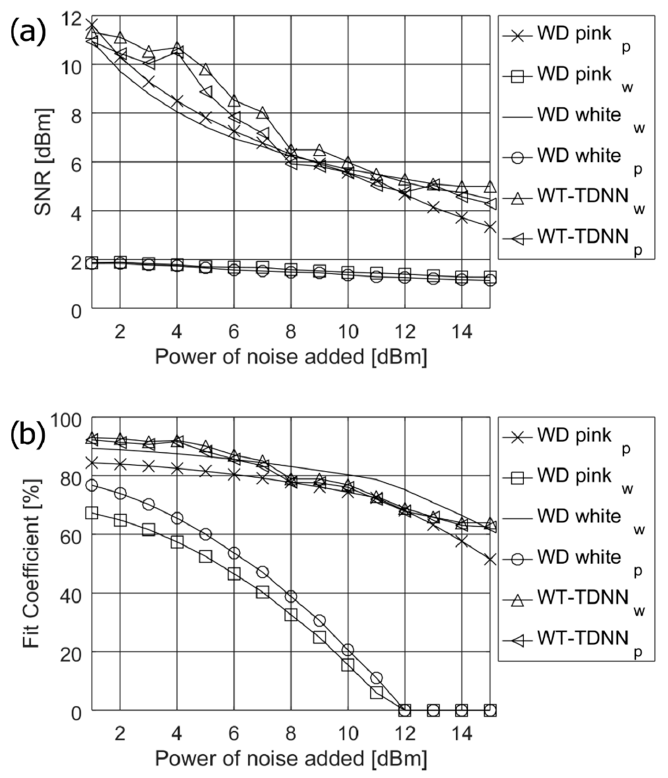
Figure 5. The performance comparison of the developed system with NN and wavelet denoising algorithms, ( a ) of SNR and ( b ) of fit coefficient .